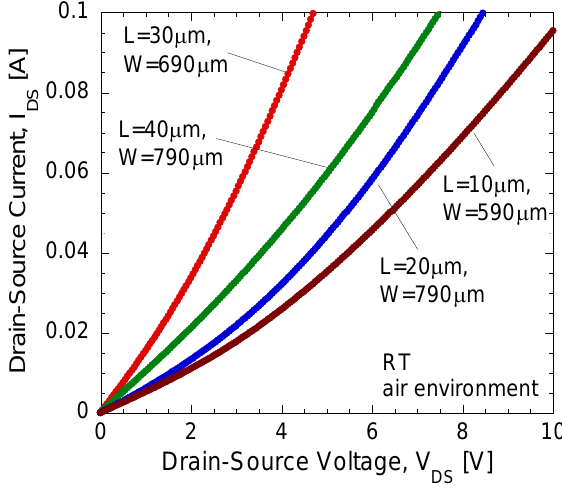
-V characteristics of the open gate HEMT in air DS DS